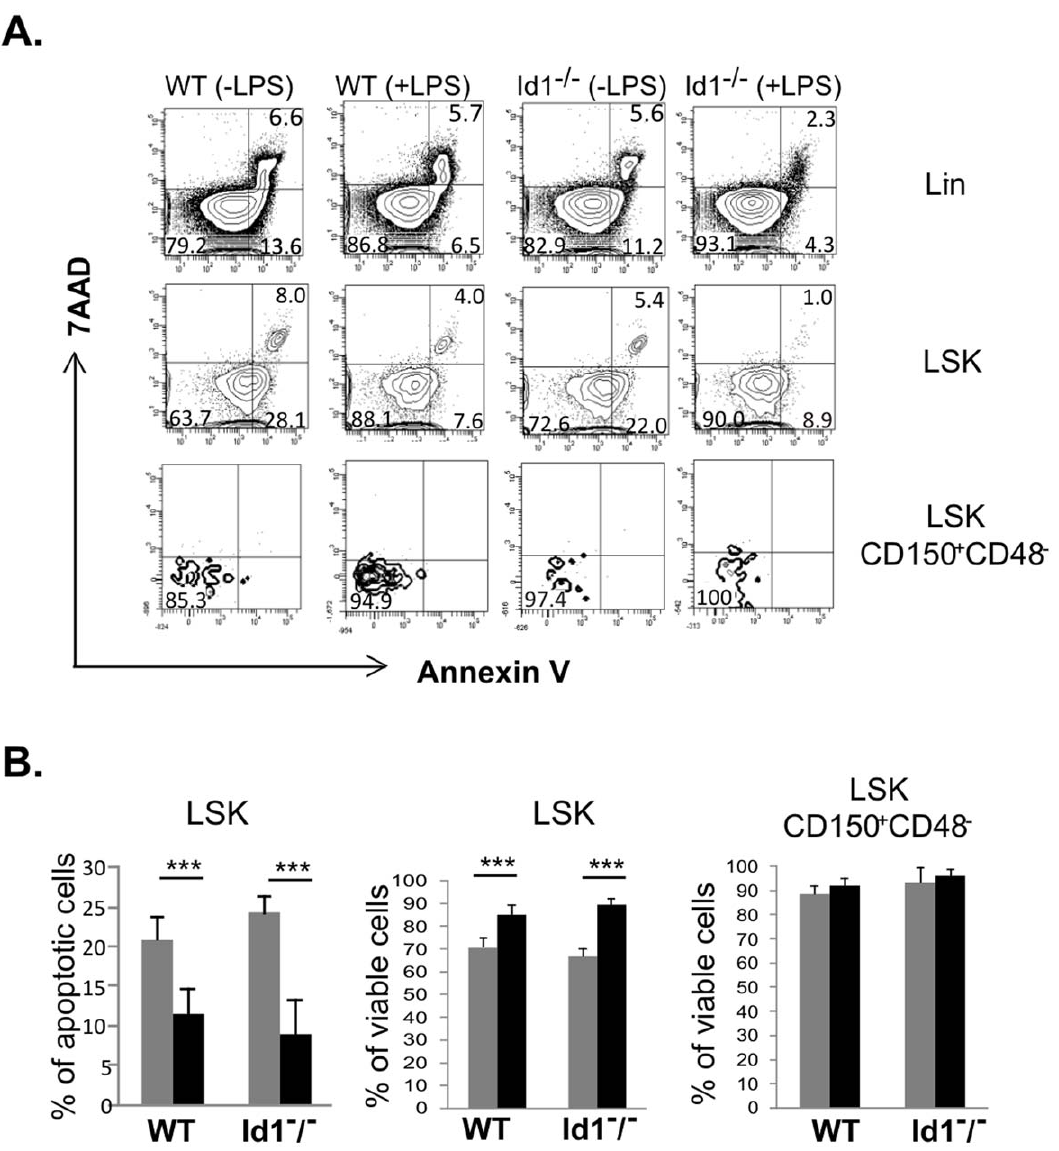
Figure 7. Analysis of apoptosis. (A) FACS analysis of indicated subsets was performed by Annexin-V and 7AAD staining. The Annexin-V positive gate was set based on its intensity on 7AAD + Lin 2 cells, which represent Annexin-V positive dead cells. Numbers indicate the percentage in each quadrant. (B) Average percentages of Annexin-V + 7AAD 2 or Annexin-V 2 7AAD 2 (viable) cells are shown with SD. Grey bar, untreated; black bar, treated with 1 m g of LPS for 30 days. *** p ,